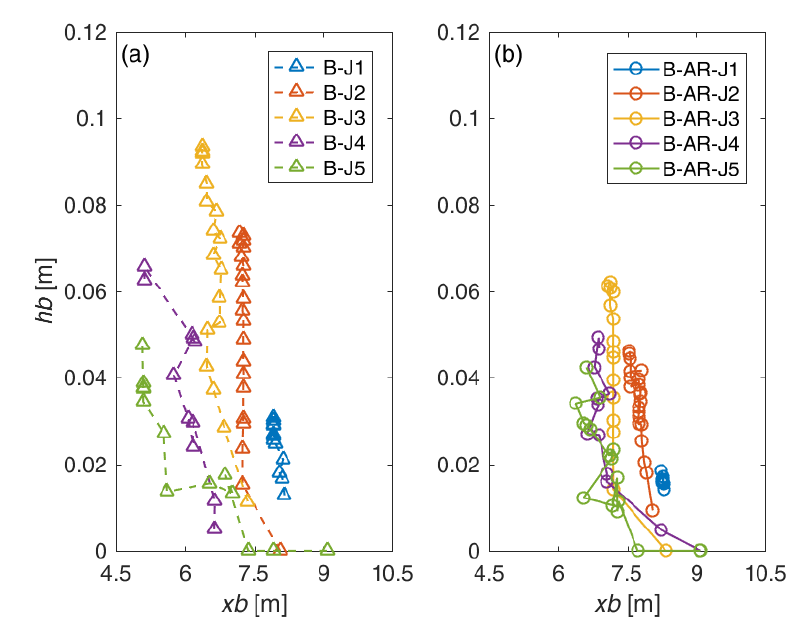
Figure 10. Maximum deposition thickness hb and its cross-shore location xb during beach evolution under irregular waves: ( a ) B tests; ( b ) B-AR tests (The time intervals of the triangles or circles are same as in Figure 7, which are 5 min for J1, 1 min for J2 and J3, 20 sec for J4, and 10 sec for J5).